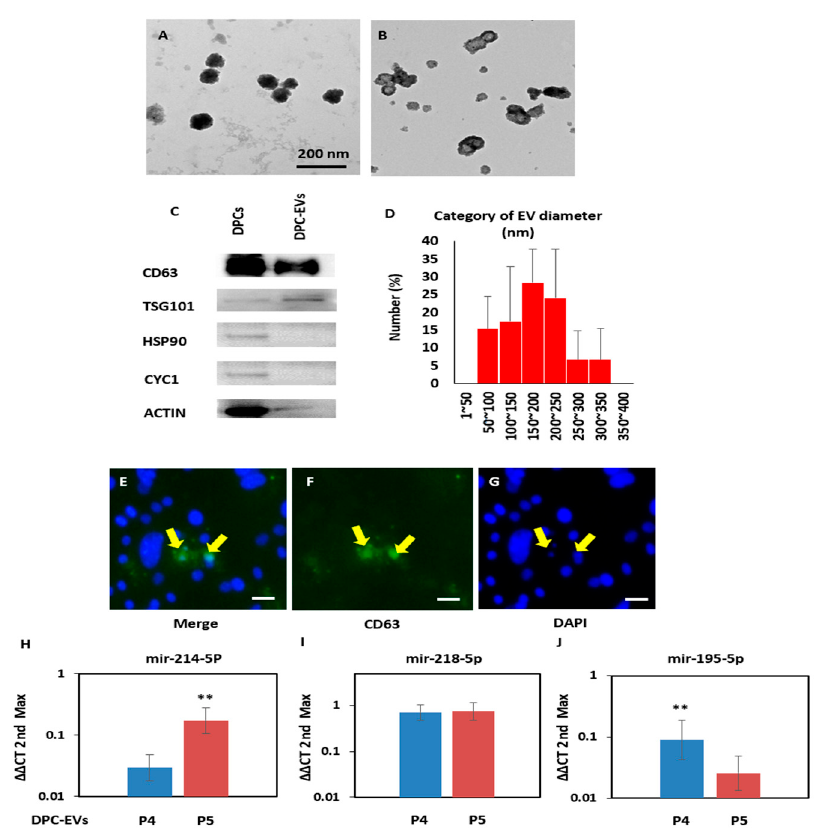
Figure 1. Isolation and detection of dermal papilla cell-derived extracellular vesicles (DPC-EVs) by transmission electron microscopy (TEM) and quantitative PCR (qPCR) analysis of miRNA expression in DPC-EVs. ( A ) DPC-EVs were detected by EV-specific anti-CD63 antibody followed by secondary antibodies conjugated with 10 nm gold beads (dense, black appearance). ( B ) As a negative control, DPC-EVs were stained with 1% glutaraldehyde, and no gold beads were attached. ( C ) DPCs and EVs were scrutinized by Western blot with specific antibodies. ( D ) The size distribution DPC-EVs were analyzed by ImageJ software 1.8.0_172. ( E – G ) Uptake of DPC-EVs by adipose-derived stem cells (ASCs). The yellow arrow indicates the EVs uptaken by ASCs; scale bar indicates 10 µ m. ( H – J ) TaqMan-based real-time PCR analysis of exosomal mir-214-5P, mir-218-5p, and mir-195-5P in P4 and P5 DPC-EVs ( n = 3). Data are presented as the mean value ± SD (Error bars). ** p < 0.01.